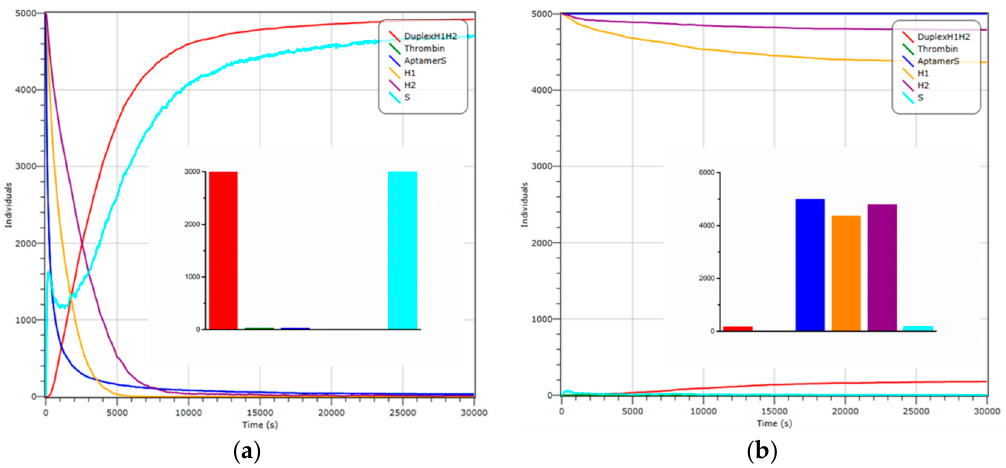
Figure 4. Visual DSD simulations. The change in the number of strands over time in the system with thrombin ( a ); without thrombin ( b ). Inset: the concentration of main strands at the equilibrium state corresponding to ( a ) and ( b ), respectively.